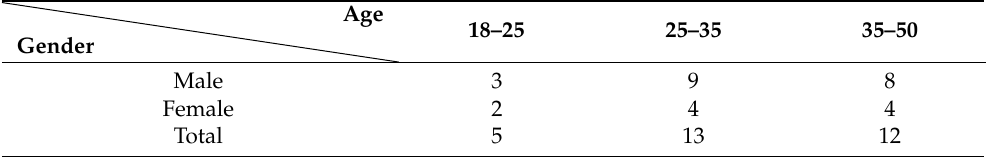
Table 1. Test sample A.